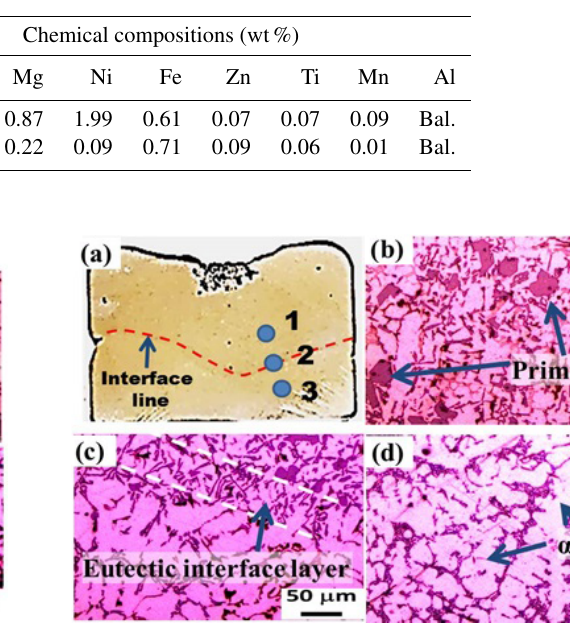
Figure 2. Macro- and microstructure of bimetal casting for a 0s time interval. (a) Macrophotograph cross section. (b, c, d) Repre- sentation of the microstructures of points 1, 2 and 3, respectively.